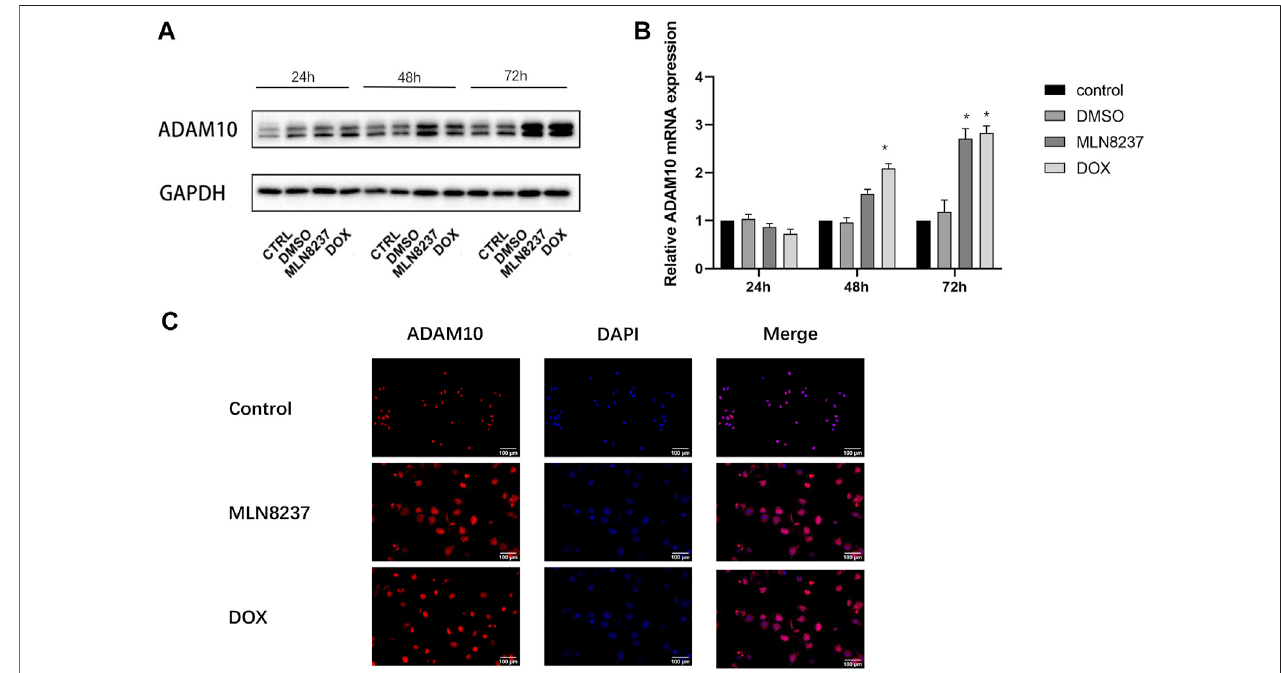
FIGURE 3 | ADAM10 expression is upregulated in senescent cells. (A) IMR-32 cells were treated with 2 μ M MLN8237, 0.5 μ M DOX, DMSO, or no treatment as a control. Cell samples were collected at 24, 48, and 72 h. (B) Western blot and qRT-PCR analyses of ADAM10. (C) IMR-32 cells were treated with 2 μ M MLN8237 or 0.5 μ M DOX for 72 h, with no treatment was used as a control. Immuno fl uorescence detection of ADAM10 expression (magni fi cation: ×20). Data represent the mean ± SEM of three independent experiments. * p <